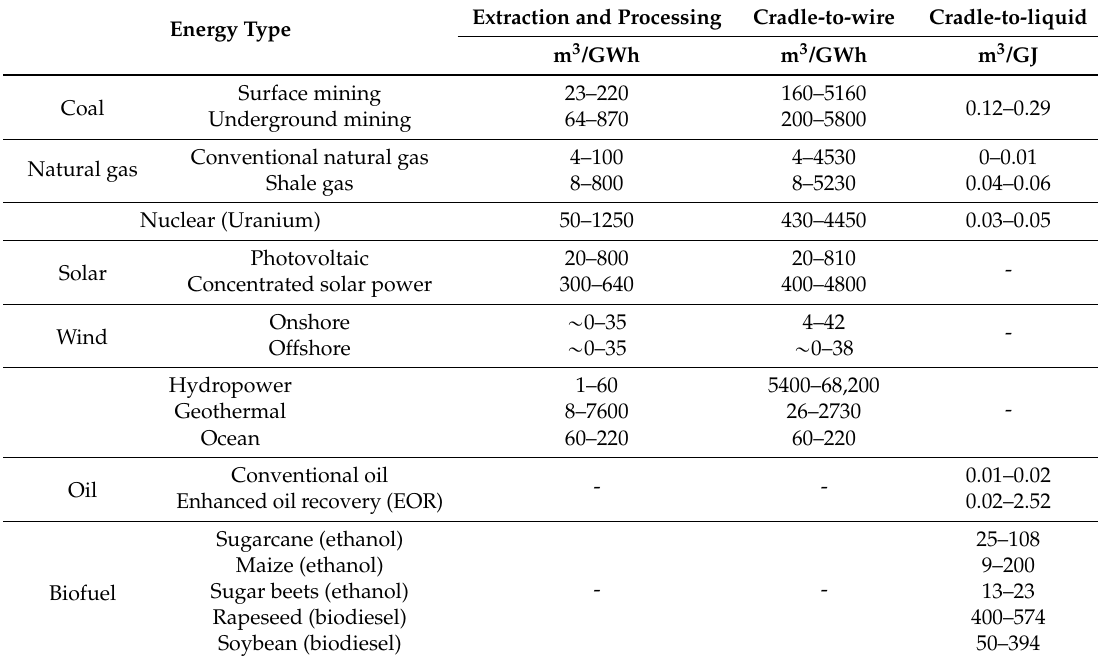
Table 1. Water consumption of different energy